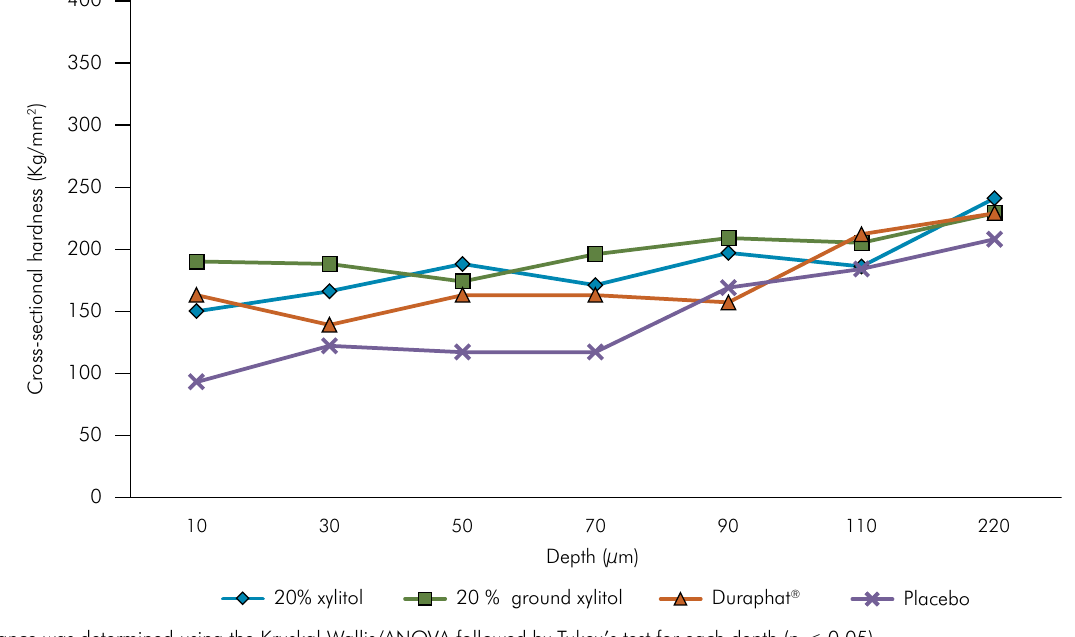
Figure 4. Subsurface hardness (kg/mm 2 ) at the different depths of the experimental groups for the permanent teeth in situ .